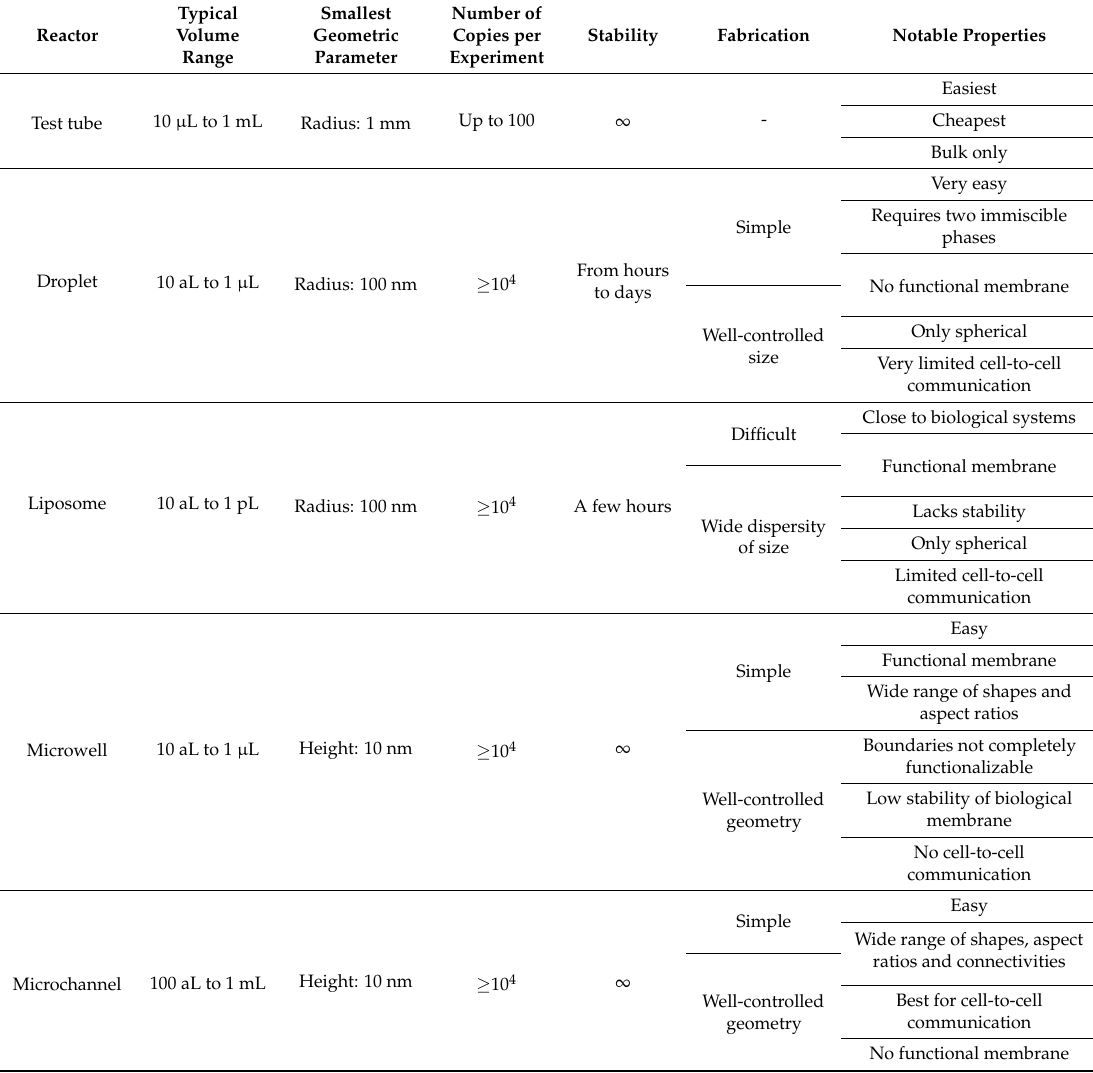
Table 1. Summary of cell-free TX-TL reactors. The geometric properties of cell-free reactors are classified with volume, characteristic length (radius or height), and shape. The density of reactors is also defined by the design of the microfluidic chip. Microwells and microchannels have large stability, but the construction of membrane-bound reactors is still